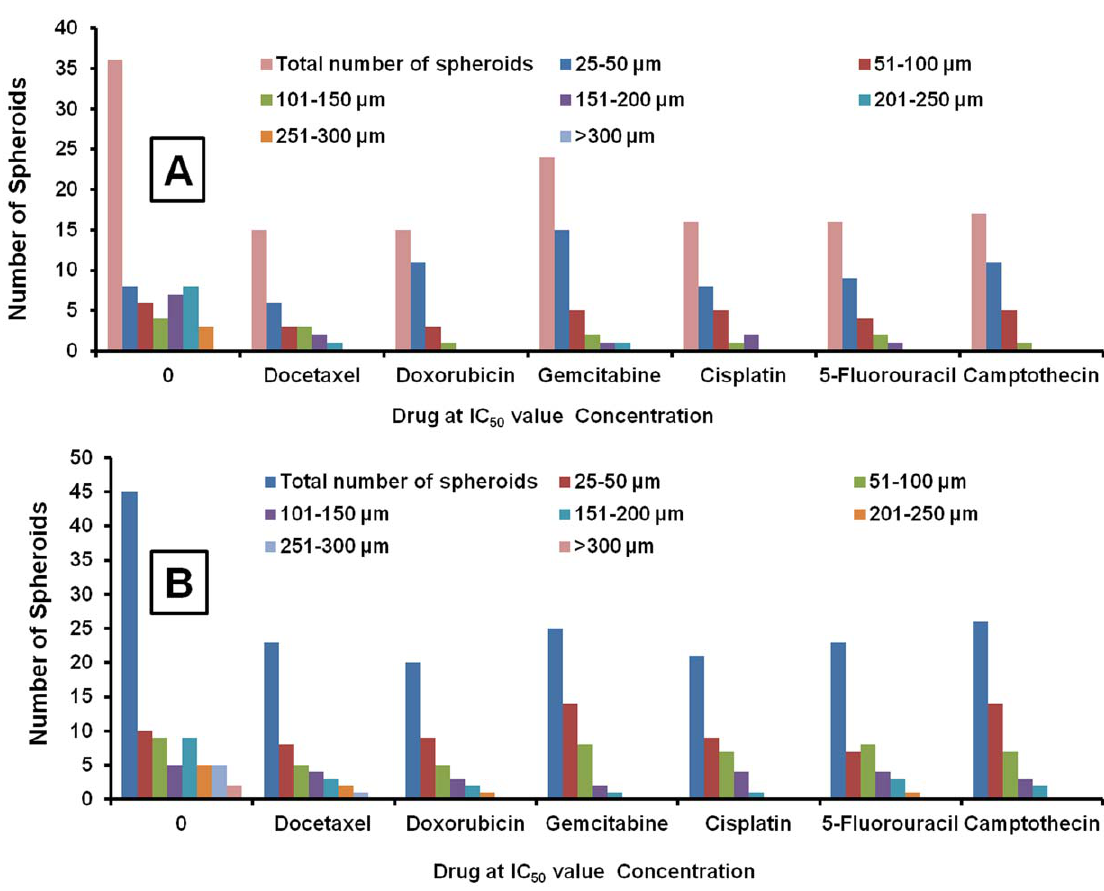
Figure 3. Comparative growth characteristics of spheroids. Total spheroid number and size distribution of H1650 parental and stem cells in 3D algimatrix scaffolds 96 well plate format. The growth characteristics of H1650 parental cells (A) and H1650 stem cells (B) at IC 50 concentrations of various anticancer drugs (generated on H1650 parental cells).